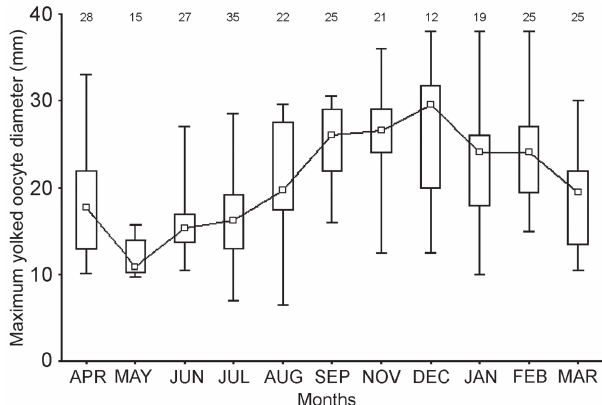
Fig. 10. Monthly variation of the mean diameter of the maximum yolked ovarian oocyte (MOD) of mature females of Sympterygia bonapartii from San Matías Gulf (Argentina). Boxes indicate the percentiles 25-75%; the inner square indicates the median value and bars the range of data distribution. Individuals sampled during September and October were analyzed together. The number of samples is given in black.